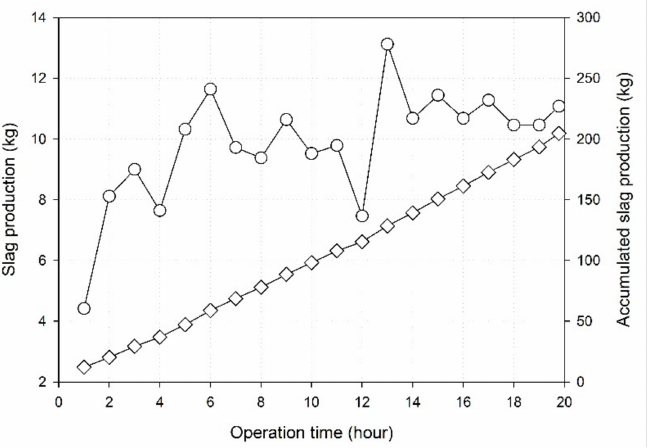
Figure 12. Pilot plant slag production mass